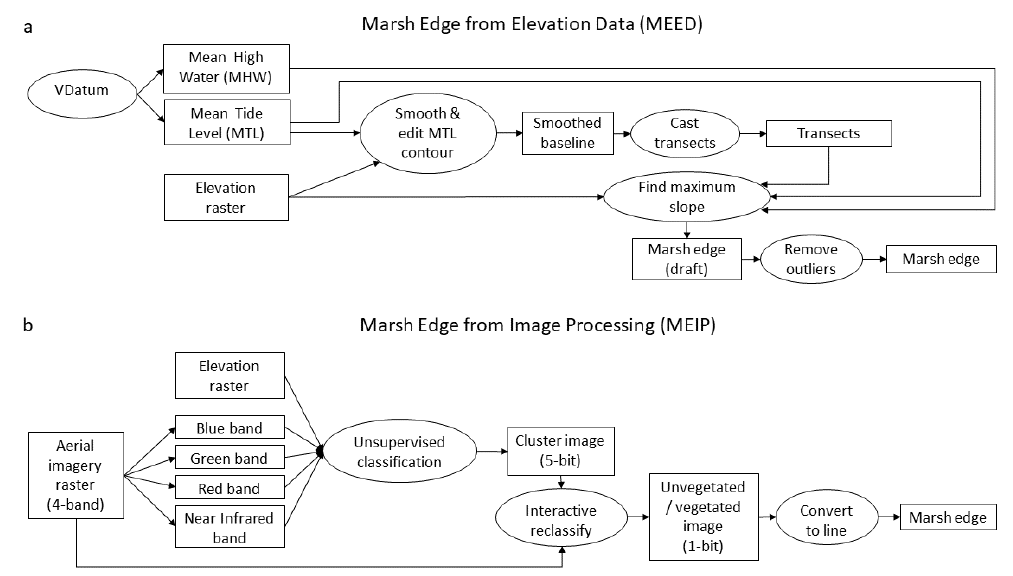
Figure 3. Flow charts for ( a ) marsh edge from elevation data (MEED) and ( b ) marsh edge from image processing (MEIP)